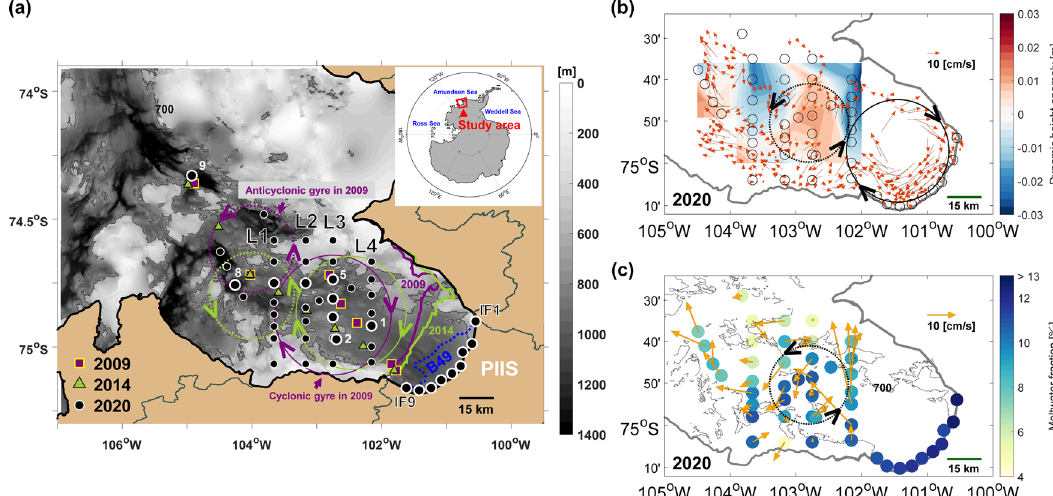
Fig. 1 Circulation in PIB in 2020. a Hydrographic observation map near PIIS from January – February 2020 overlaid on a local high-resolution bathymetry chart 28,48 . White-rimmed black circles represent the positions of 2020 Conductivity-Temperature-Depth (CTD) data presented in Fig. 2. The selected CTD stations are numbered in an order of distance from PIIS. L1-L4 and IF indicate CTD observational lines aligned meridionally across PIB and along PIIS, respectively. Solid purple and green lines represent the PIIS front positions in 2009 and 2014, respectively. The solid black line indicates a new ice shelf front after the calving of the ‘ B49 ’ iceberg (dashed blue line) from PIIS on 9 February 2020. The large solid and dotted purple circles (green circles) with arrows indicate the approximate extents of the cyclonic and anticyclonic gyres observed in 2009 20 (2014), respectively. These extents of gyres are referred to from Supplementary Fig. 1. Dark grey contour denotes the grounding line. b Red-faced arrows denote the ocean currents averaged over depth ranging from 30 to 300 m based on Ship-based Acoustic Doppler Pro fi ler (SADCP) data collected in 2020, gridded into ~3 × 3 km horizontal boxes. Shading represents the dynamic height anomaly (Methods). The large solid (dotted) black circle with arrows denotes the approximate size and position of the cyclonic (anticyclonic) gyre in 2020. Small black circles denote the positions of CTD stations. c Orange-faced arrows indicate the ocean currents averaged over depth ranging from 30 to 300 m based on the Lowered Acoustic Doppler Current Pro fi ler (LADCP) data. Colour- fi lled circles indicate the vertically averaged meltwater fraction above the mCDW